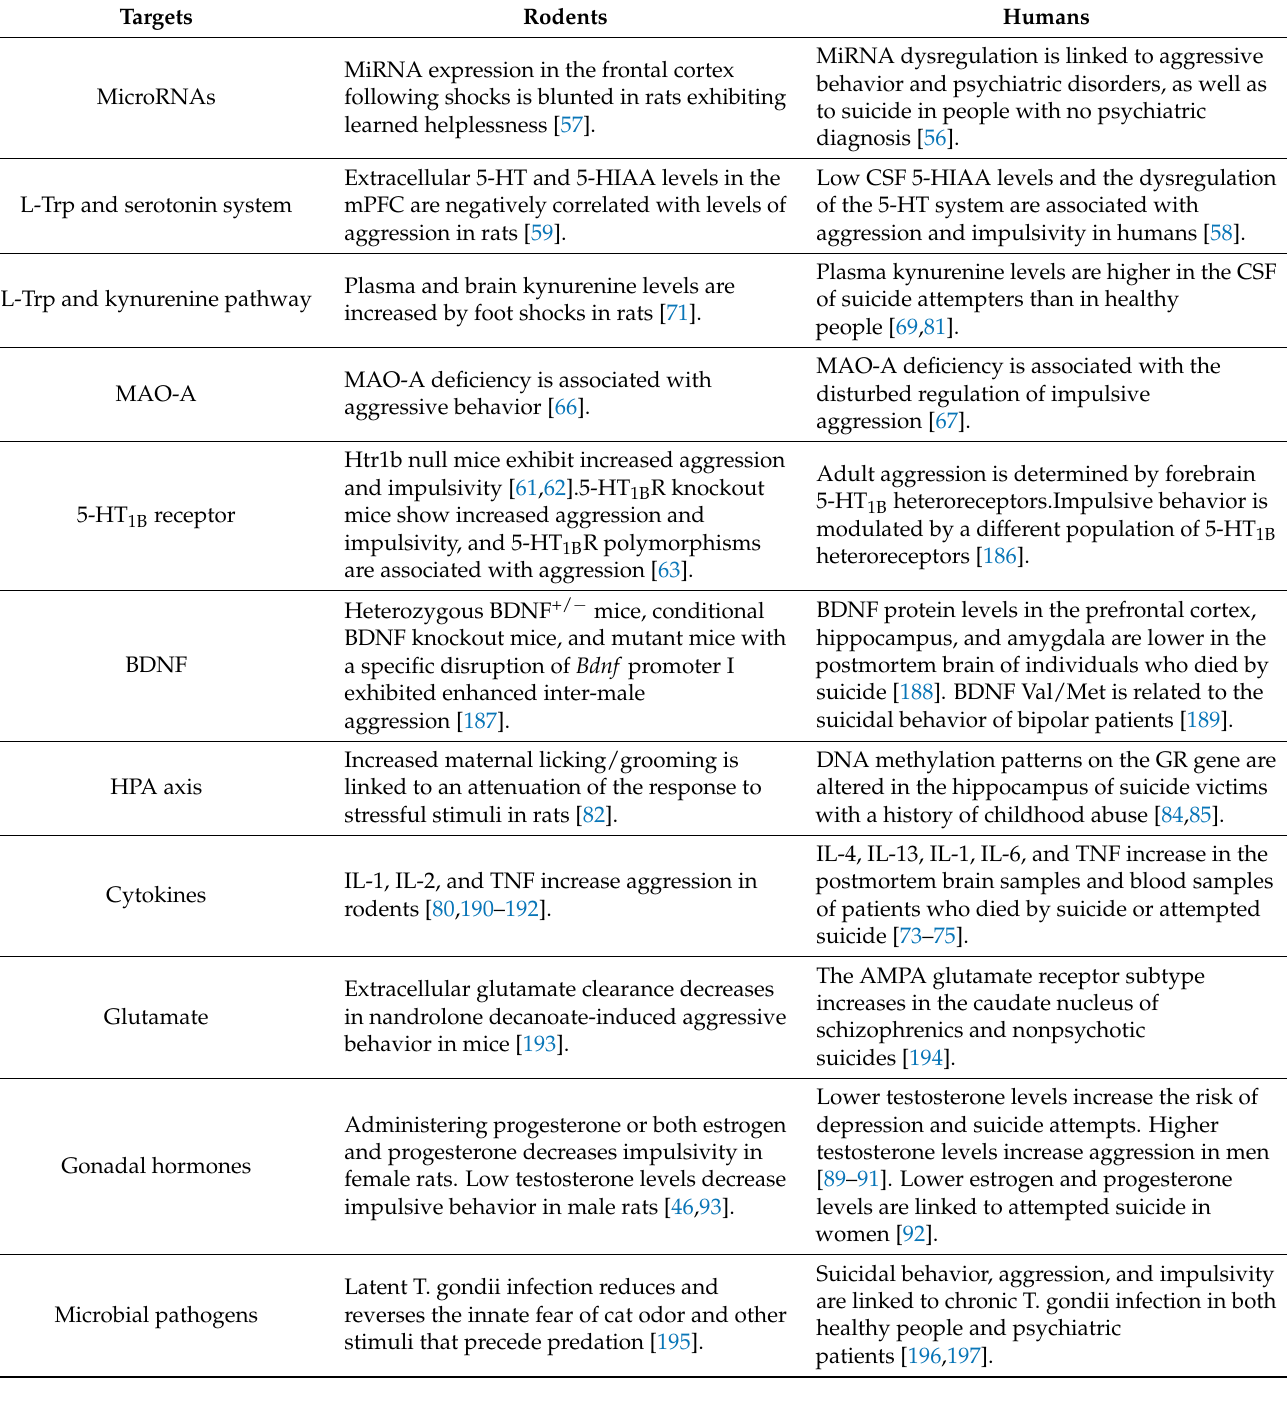
Table 1. Endophenotypes of suicidal behavior as studied in animal models and